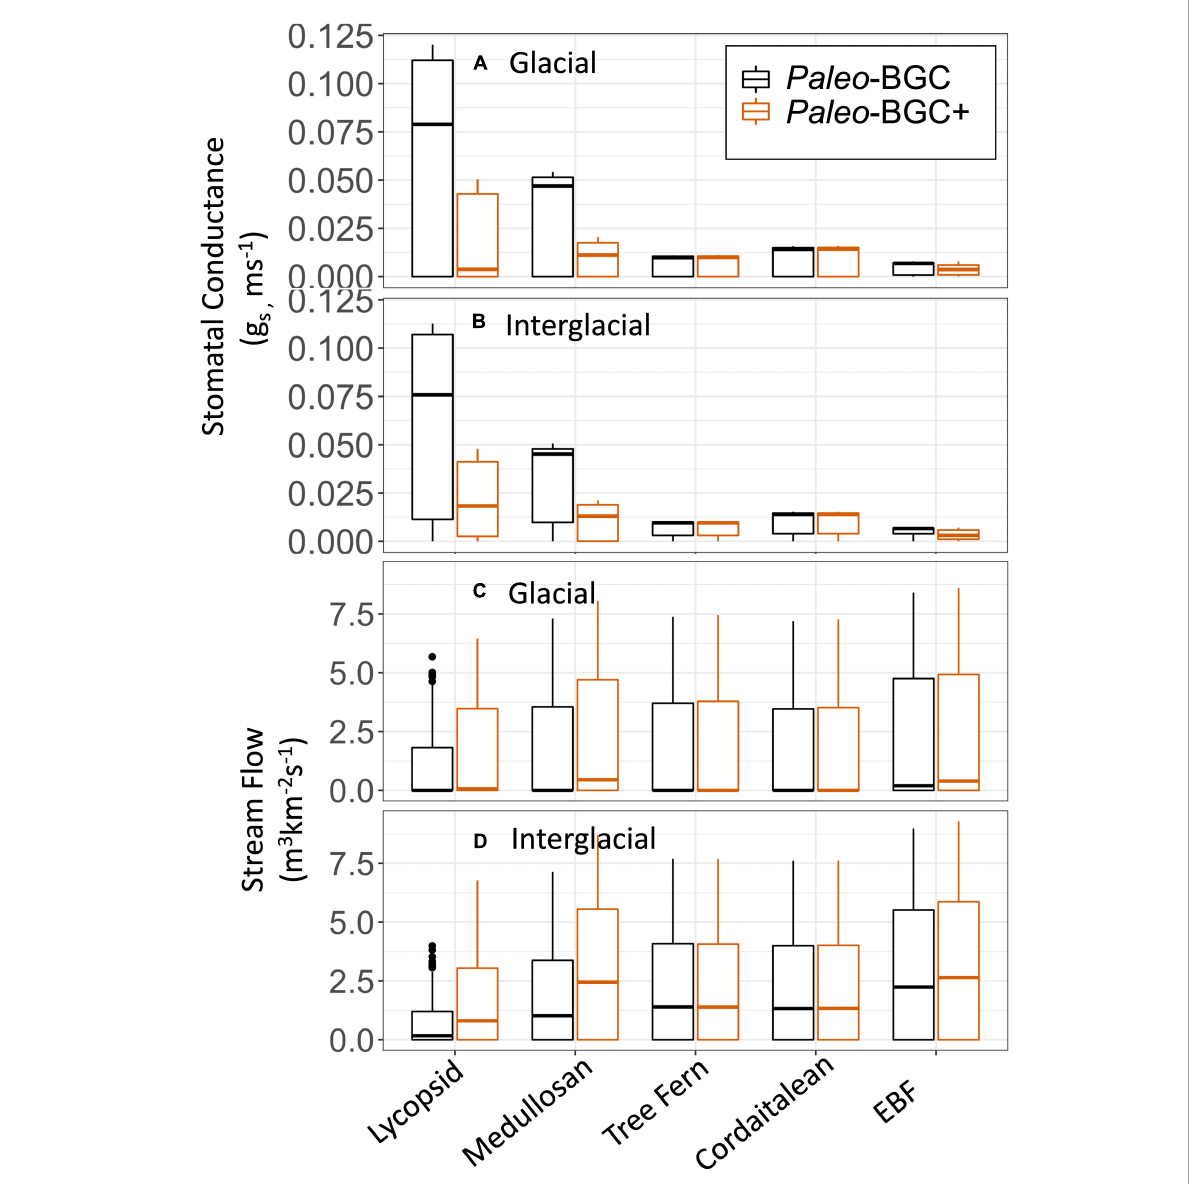
FIGURE7 Simulated average water cycle fluxes from two ecosystem process model implementations ( Paleo -BGC, Paleo -BGC+) that differ in their representation of sapwood physiological limitation of stomatal conductance. Four fossil and two extant plant types were simulated under tropical wetland conditions in the Carboniferous Period. Stomatal conductance (g s , A,B ) was reduced and stream flow increased (C,D) for plant types that are vulnerable to sapwood dysfunction (lycopsid and medullosan). Extant plant types (EBF-V, EBF-R) are averaged to clarify presentation